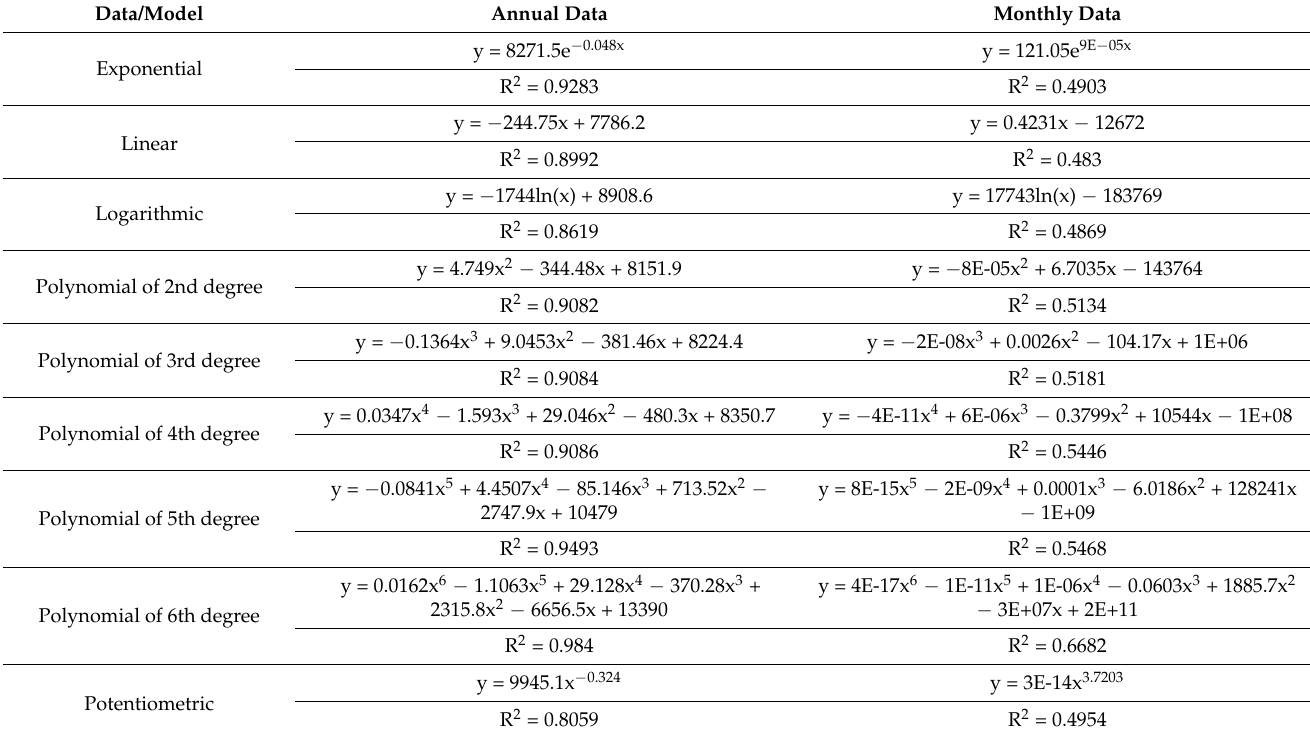
Table A7. Trend models for the Masovia